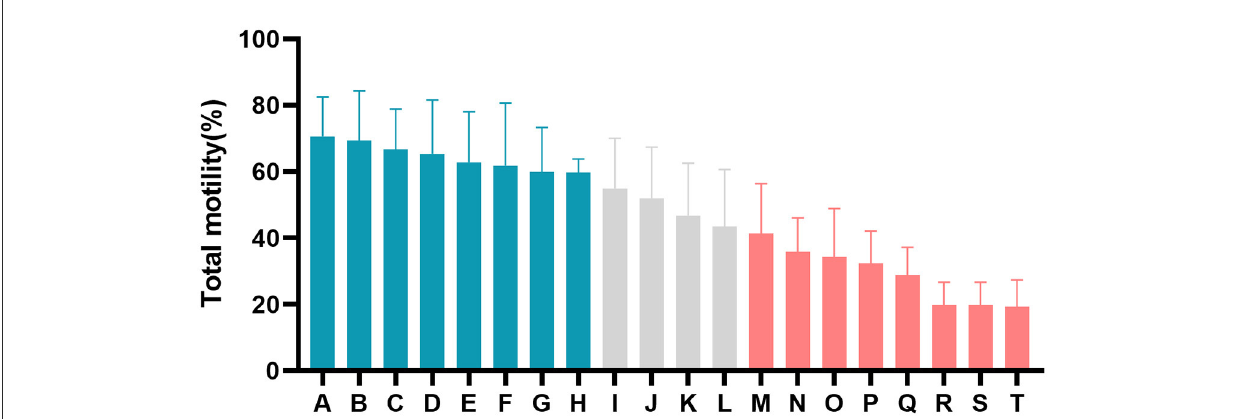
FIGURE1 Difference in percentage total motility of post-thaw spermatozoa from all goats (A–T). The blue columns represent goats from the high-freezability (HF) group, the red columns represent goats from the low-freezability (LF) group, and the gray columns indicate goats with sperm classified as medium